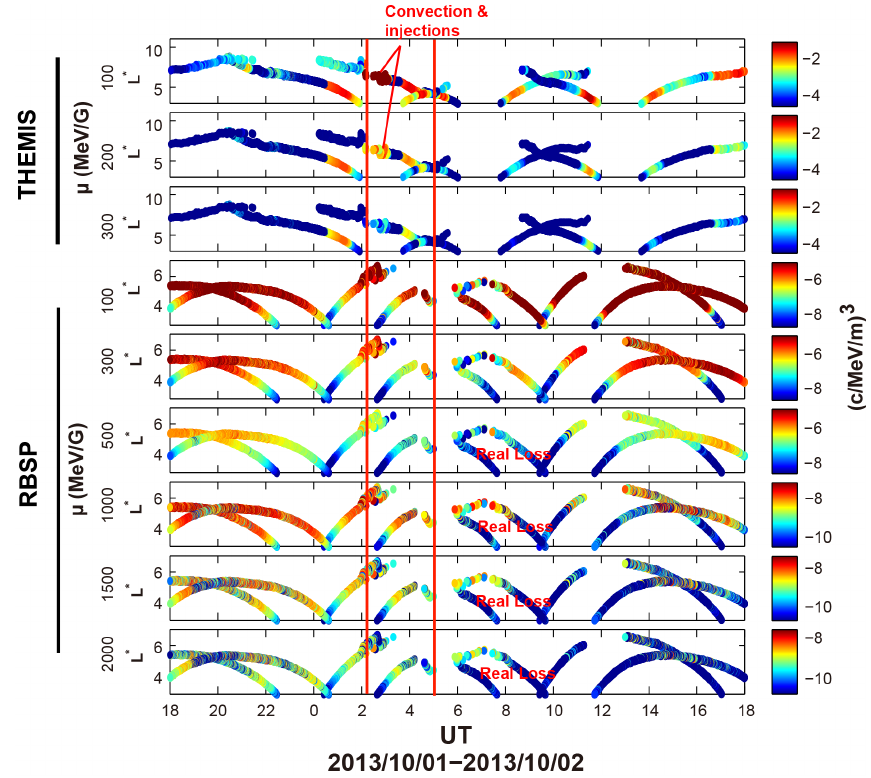
Figure 7. Computed electron PSDs for THEMIS and Van Allen Probes corresponding to a fixed value of K = 0 . 05 G 1 / 2 R E and a group of µ values. The red lines indicate the start time of P dyn pulses. The calculations of L ∗ are performed using the TS04s geomagnetic field